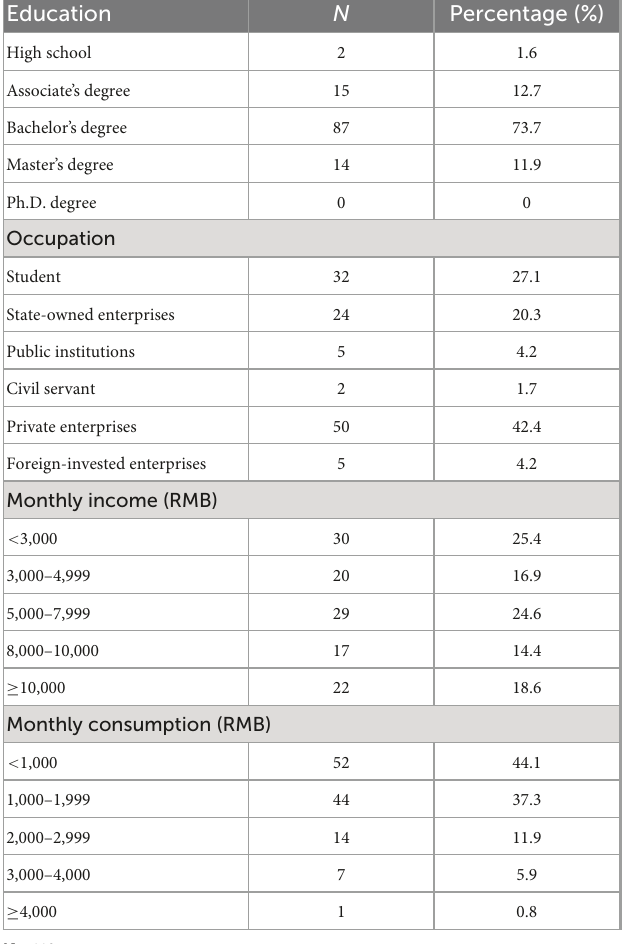
TABLE 5 Description of participants’ demographics in Study